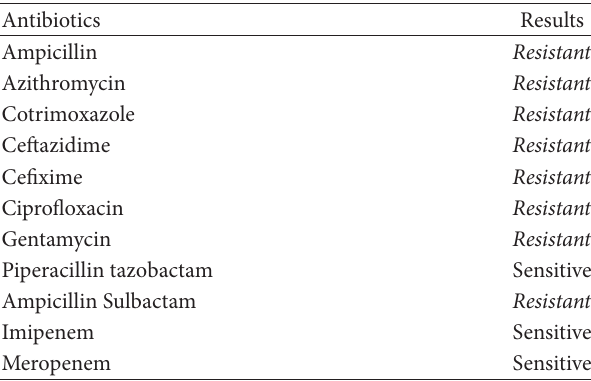
Table 1: Antibiogram of Shigella flexneri isolated from two